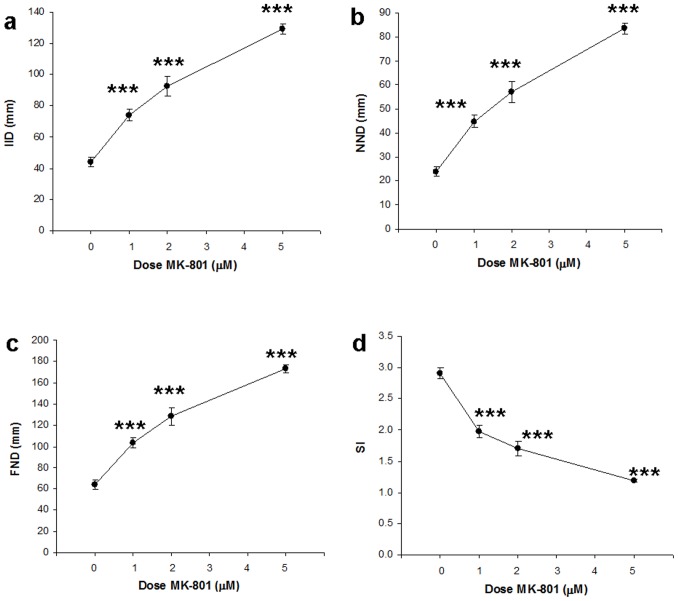
Social cohesion of the homogeneous shoals in experiment 1.All four measures of social cohesion show that with increasing drug concentration cohesion decreases. (a) IID, inter-individual distance, (b) NND, nearest neighbor distance, (c) FND, farthest neighbor distance, and (d) SI, shoaling index, are presented. Means ± SEMs are shown. Significant differences between MK-801 groups and controls: ***p<0.001. For 0, 1 and 2 µM MK-801, n = 20. For 5 µM, n = 19.